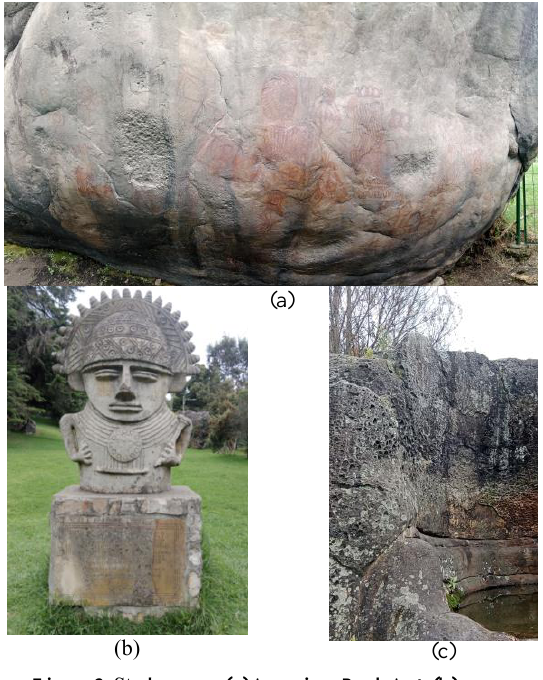
Figure 2. Stu dy areas. (a) American Rock Art, Petroglyph, (c) Las Moyas